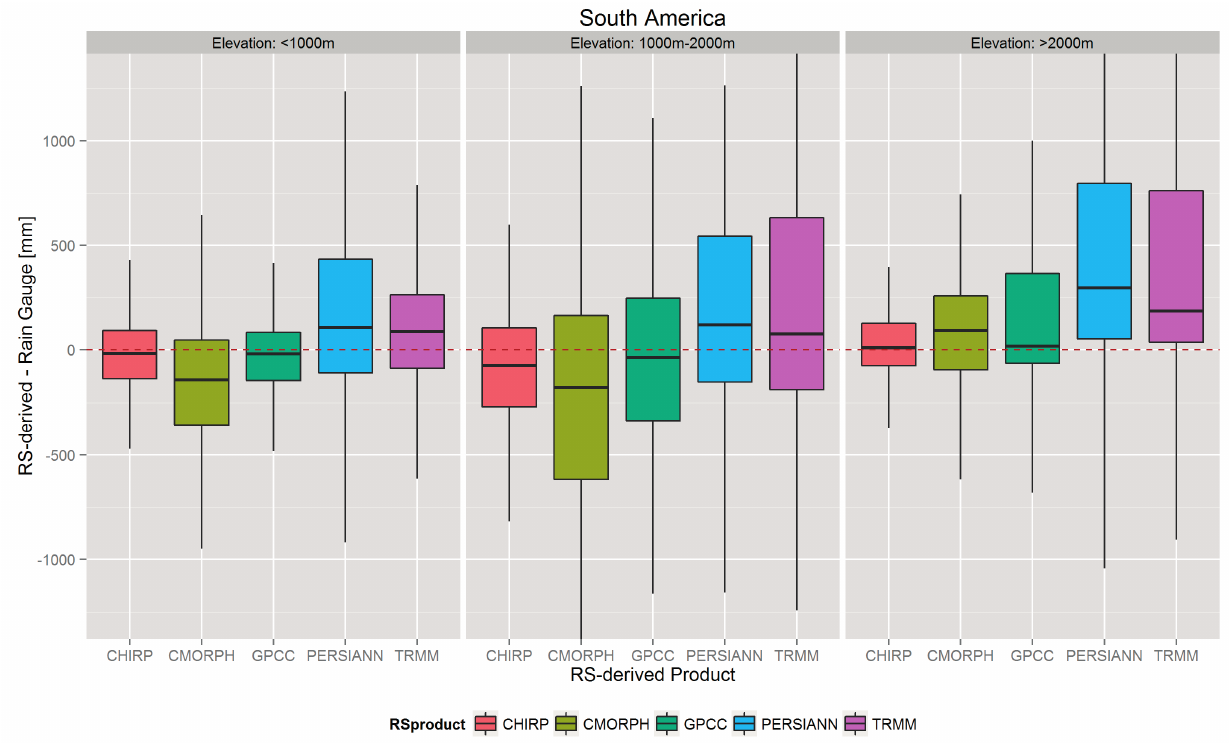
Figure 9. Box-and-Whiskerplot of the difference between downscaled and observed precipitation for different elevation classes across the entire South America.